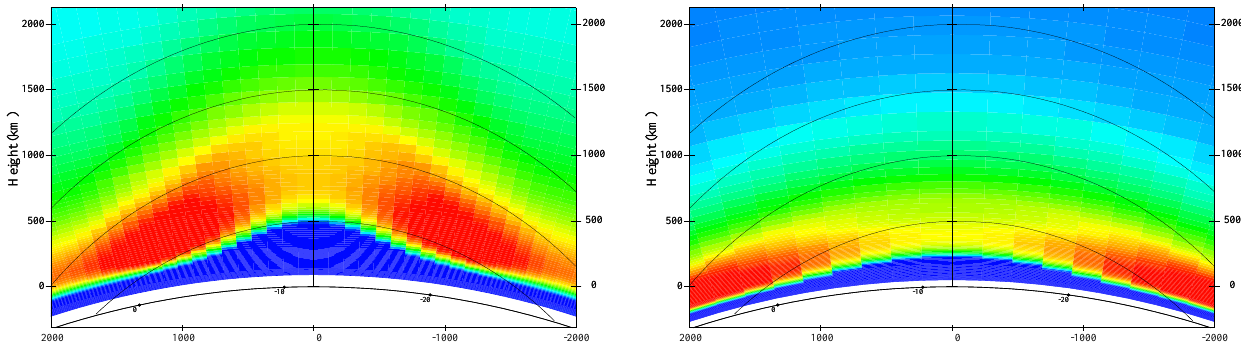
Fig. 13. Schematic representation showing two possible scenarios of the latitudinal distribution of the F-region densities during events that support the initiation and the development of plasma depletions. Note the difference in the altitude of the F-region near the magnetic equator and the locations of the Anomaly Figure 13.